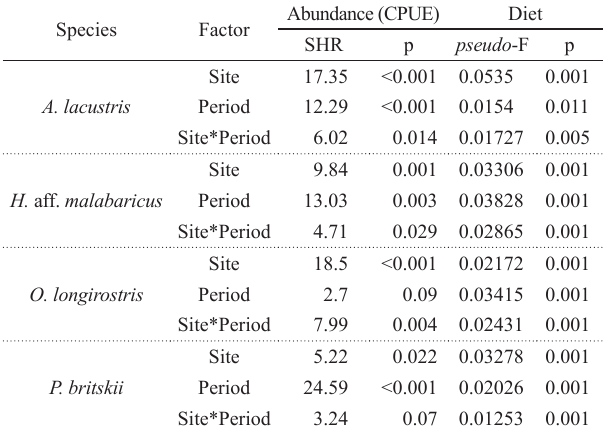
Table 1. Scheirer-Ray-Hare test and Permutational Multivariate Analysis of Variance applied to